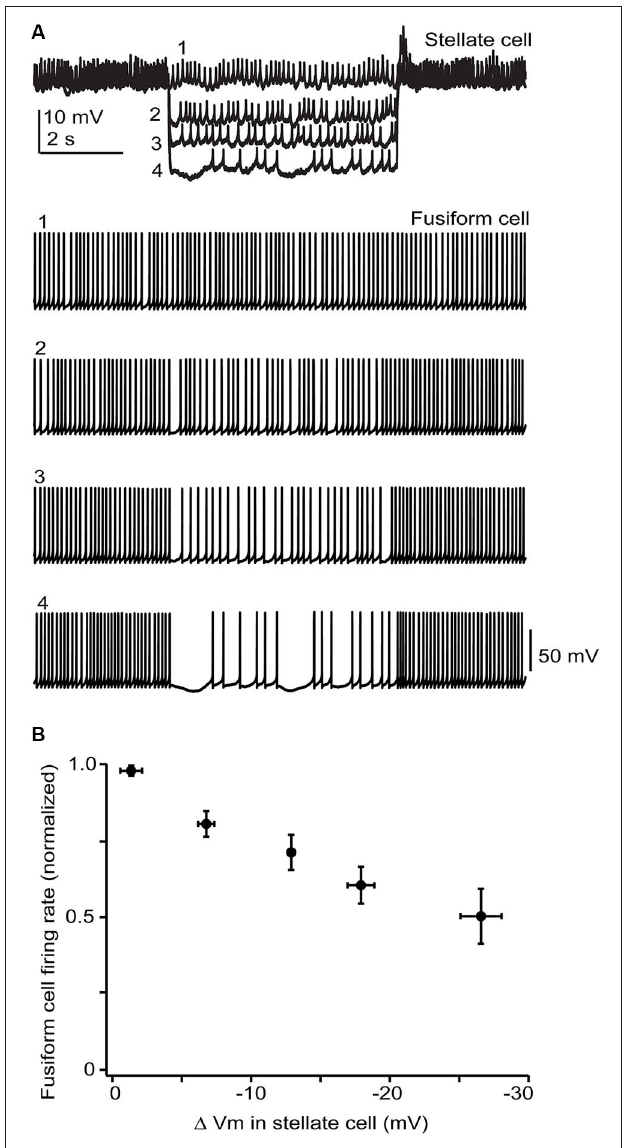
FIGURE 6 | Stellate membrane potential modulates fusiform spontaneous spike rate. (A) In an electrically coupled cell pair, injection of hyperpolarizing current steps into the SSC shifted the SSC potential up to 20 mV negative to the resting potential of − 65 mV and had a clear inhibitory effect on fusiform spontaneous spiking. (B) Average data from 5 cell pairs shows a near linear dependence of fusiform cell spike rate on SSC membrane potential. Firing rates varied widely among fusiform cells and so were normalized in each cell to the rate during the baseline condition where no hyperpolarizing current step was injected into the stellate